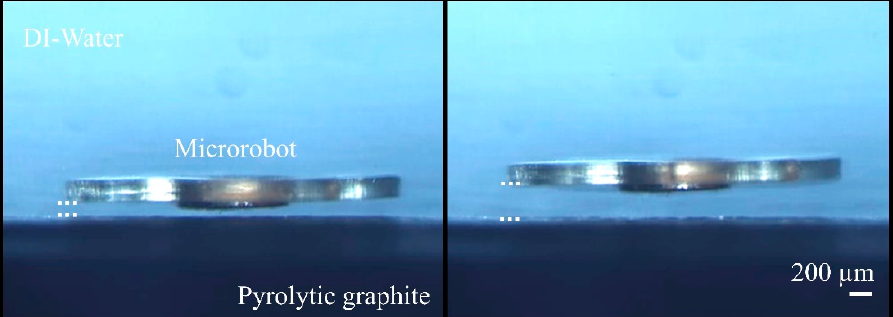
Figure 11. The left picture shows minimum levitation height of the microrobot (30.0 µm) and maximum levitation height (333.8 µm) on the right picture.